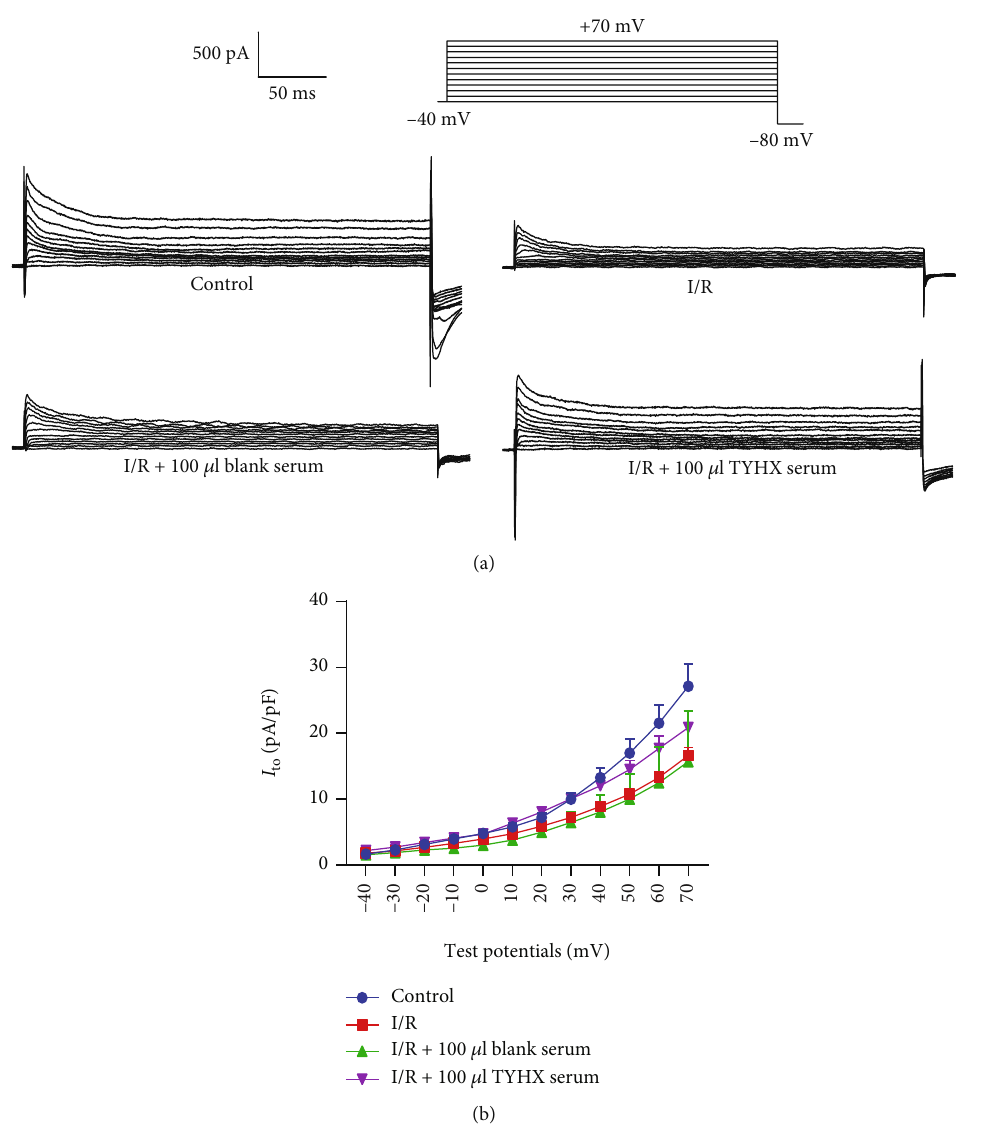
Figure 2: The e ff ects of TYHX on current-voltage relationship for I I to